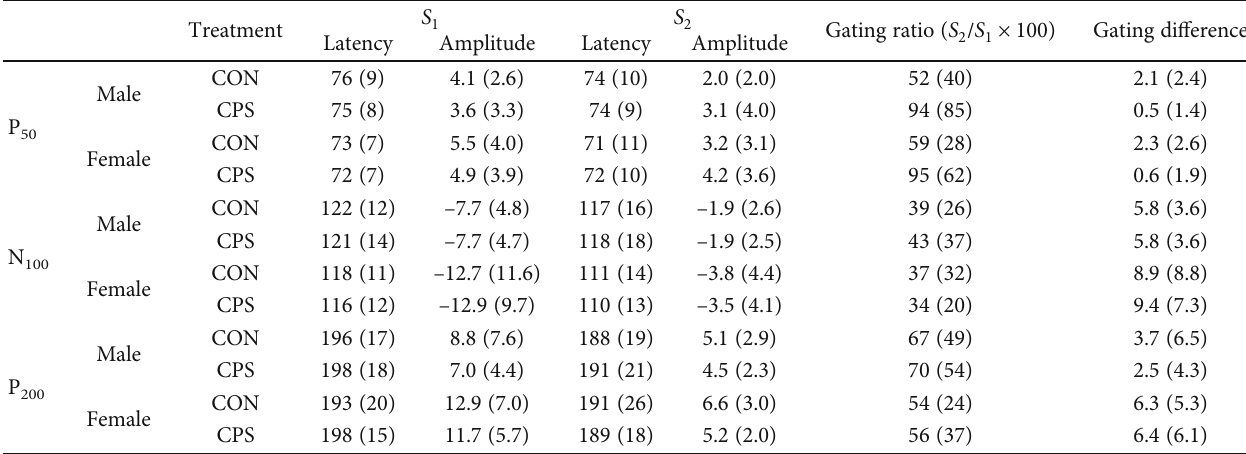
, (b) S ) for both genders during two 1 2 , N , and P , M ð SD Þ 50 100 200